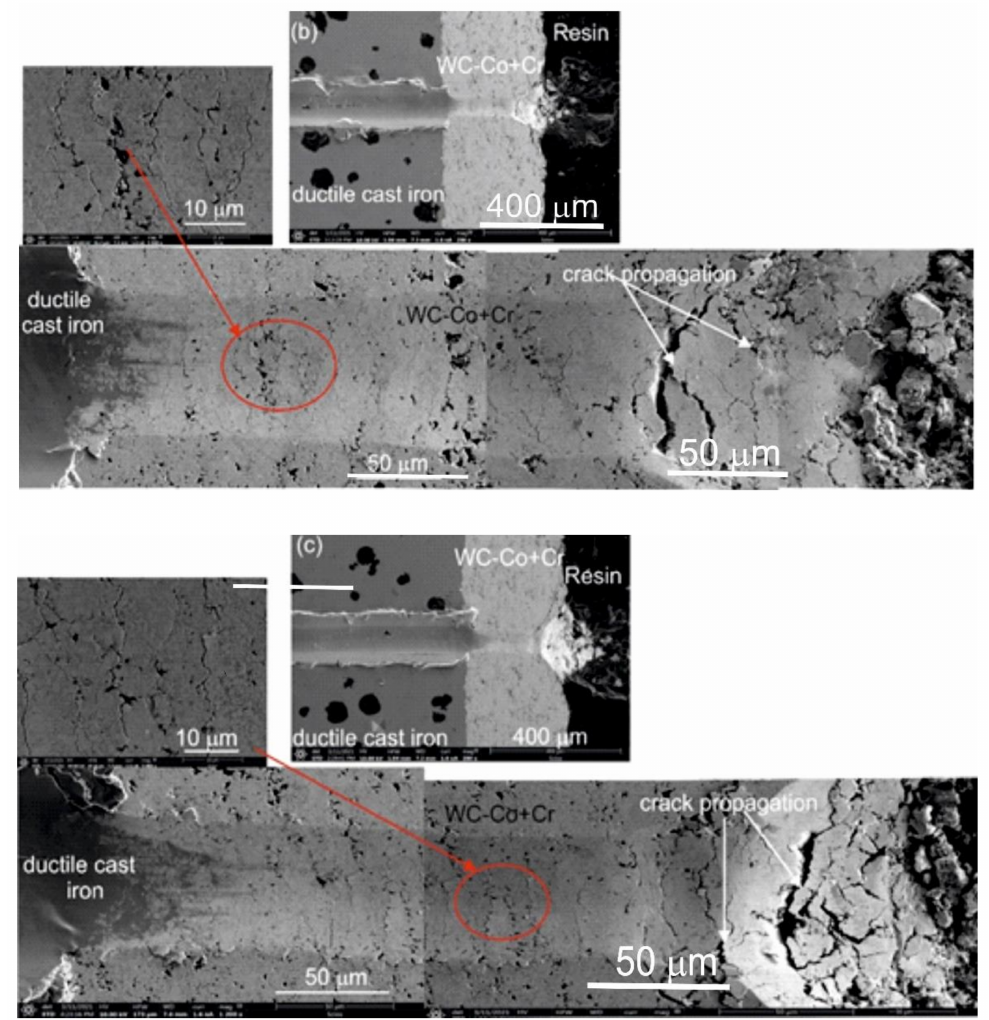
Figure 10. SEM micrograph of the cross-sectional area of the WC–Co + Cr/ductile cast iron system cracked after the scratch test at load: ( a ) 10 N; ( b ) 20 N and ( c ) 25